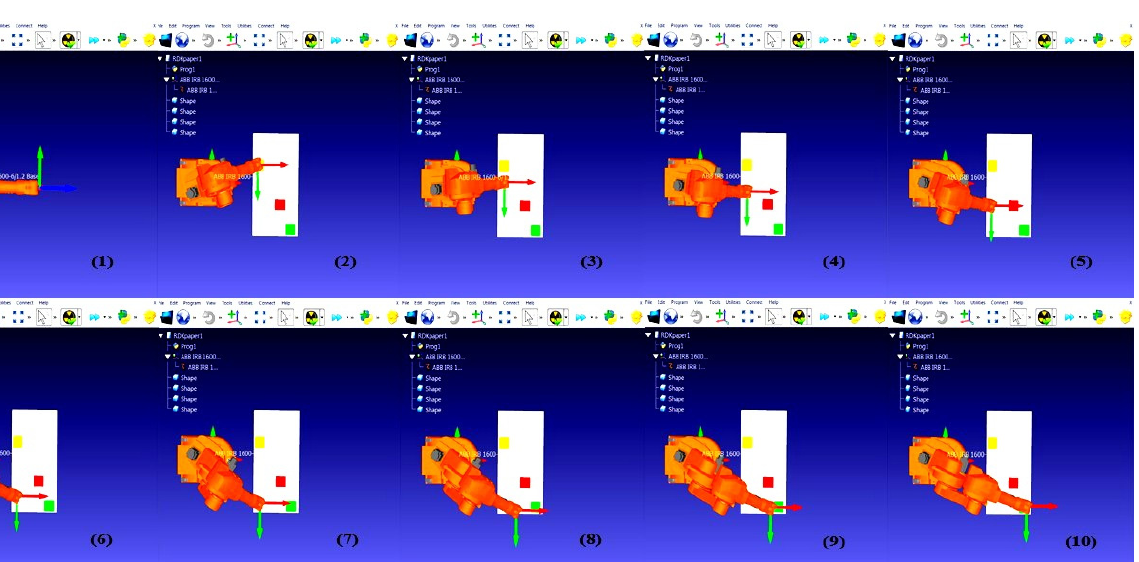
Figure 7. Experimental setup: camera, robot arm, workspace, yellow start, red obstacle, green target, computer.